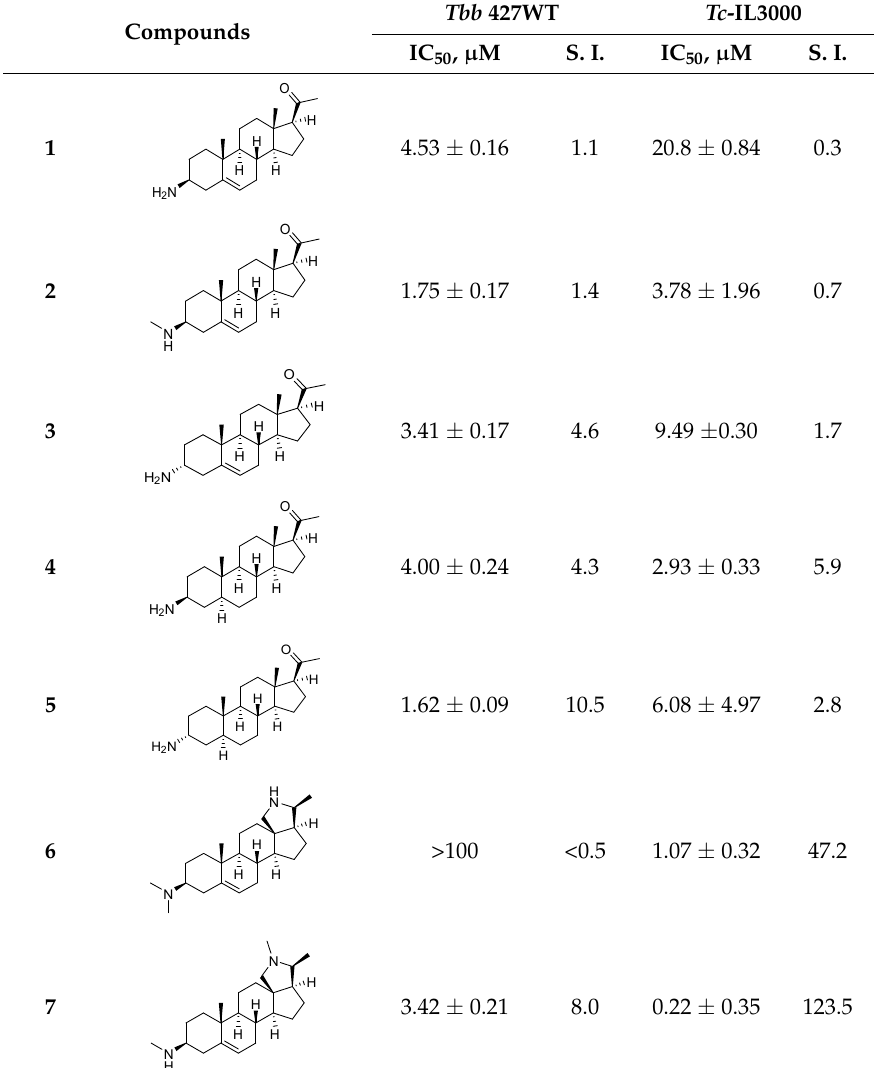
Table 1. In vitro activities of some 3-aminosteroids against wild-type T. b. brucei (Tbb 427WT) and Tc- IL3000.